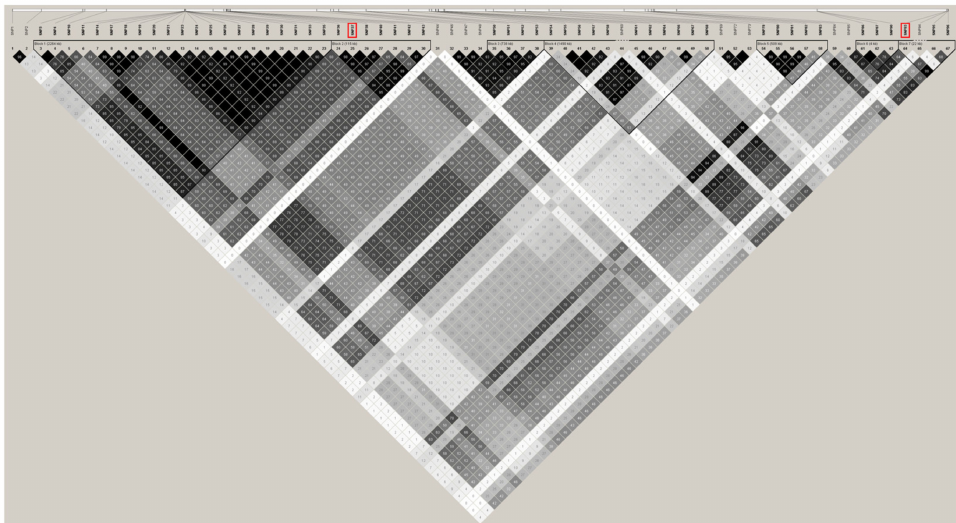
Figure 1. SNPs’ significance plot for BMS and LD block from 10 to 30 Mbp on BTA7 in Hyogo population. The x -axis indicates chromosome 7 positions in base pairs, and the y -axis indicates log– inverse p -values. Significance of SNPs is represented as blue circle for independent SNP associations and as yellow triangle for SNP associations estimated by fitting SNP93_ ALDH7A1 as a fixed effect in the model. The significance of SNP93_ ALDH7A1 and SNP37_ ICAM1 SNP is represented by red circle. The dashed green line indicates the threshold of the 5% significance level. LD coefficients ( r 2 ) between the SNPs in this region. Black squares indicate r 2 values >0.80, and white and gray indicate r 2 values <0.80. SNP93_ ALDH7A1 and SNP37_ ICAM1 SNP are shown by a red frame.